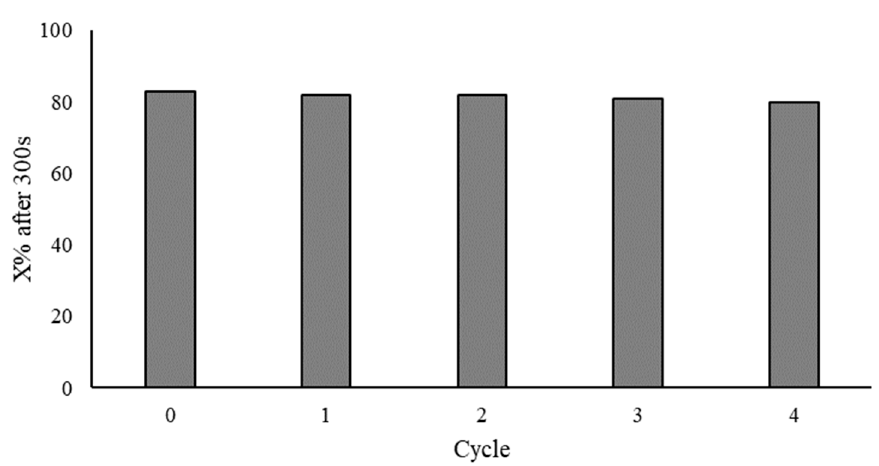
Figure 8. Plot of conversion per each run of the reusability tests.